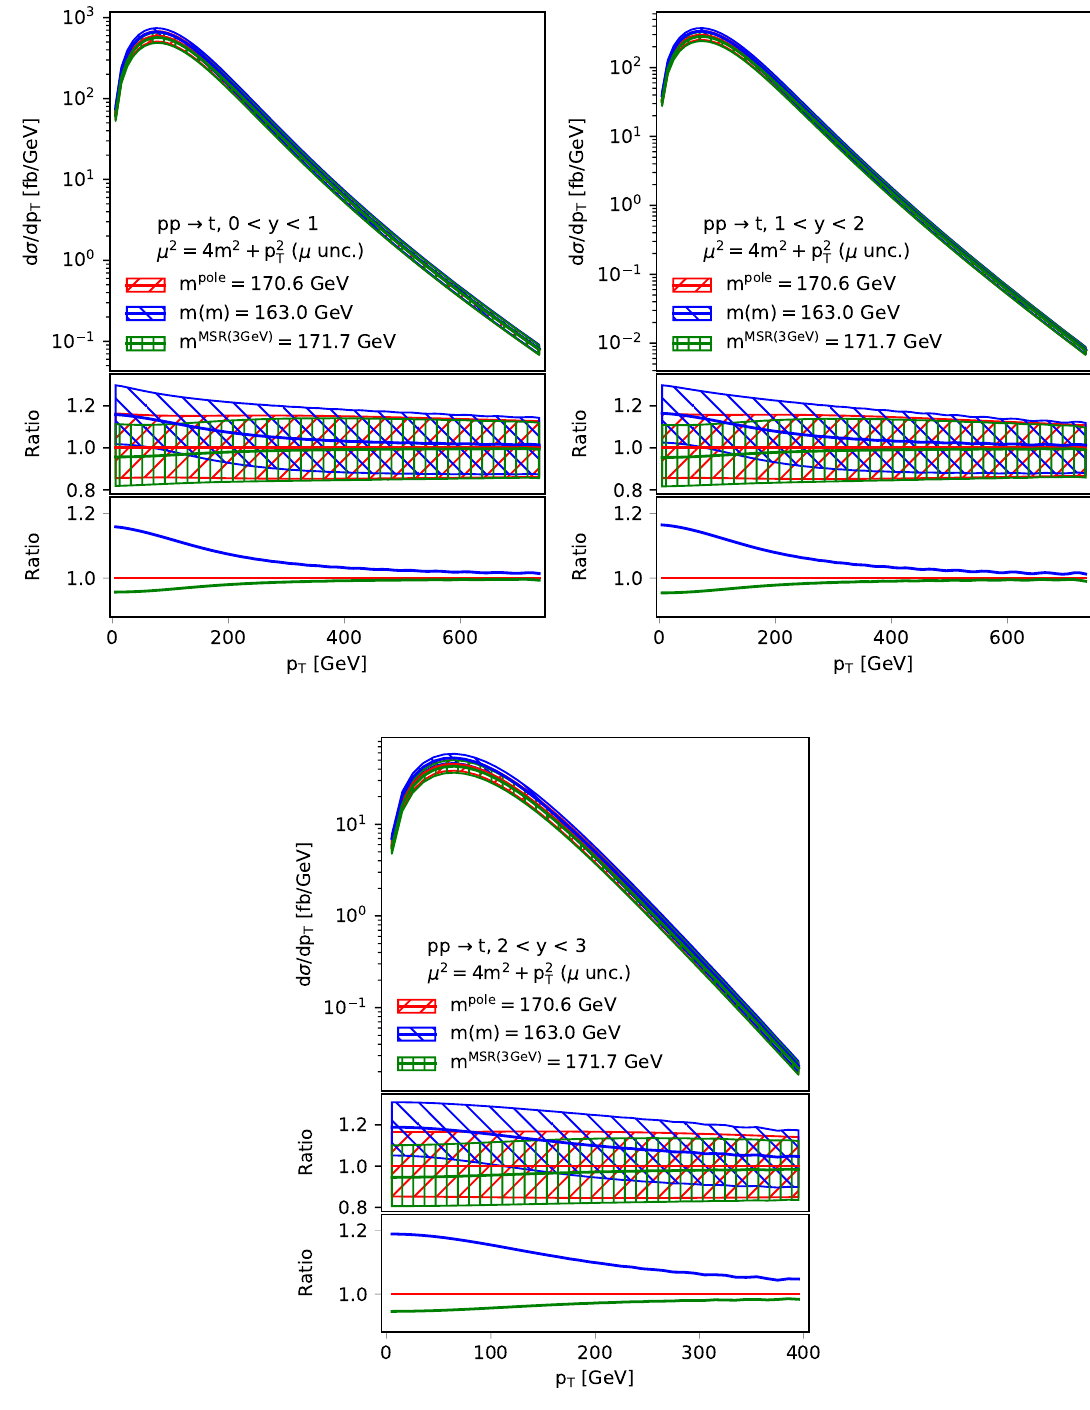
Figure 6 . Same as figure 2 for top